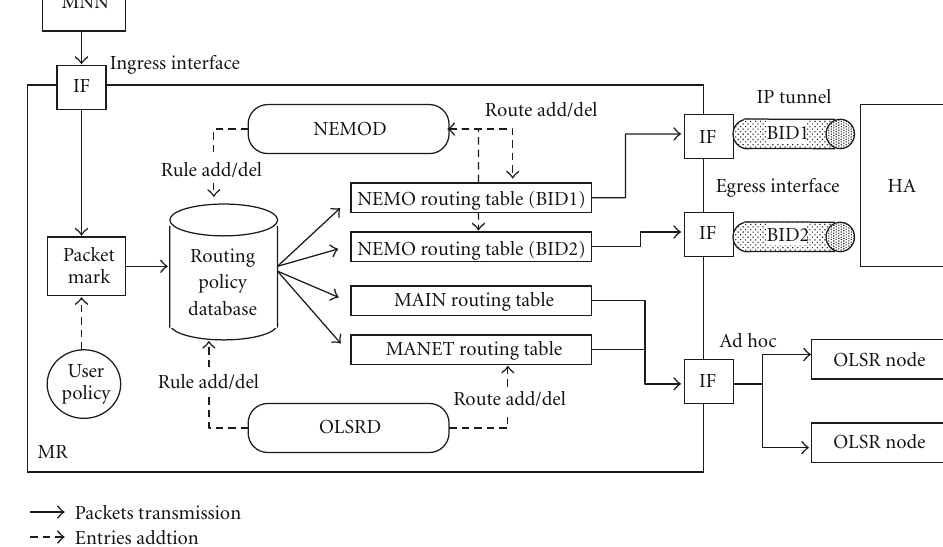
Figure 7: Internal route updating and selection mechanisms. NEMO and OLSR routes are stored in completely independent routing tables.